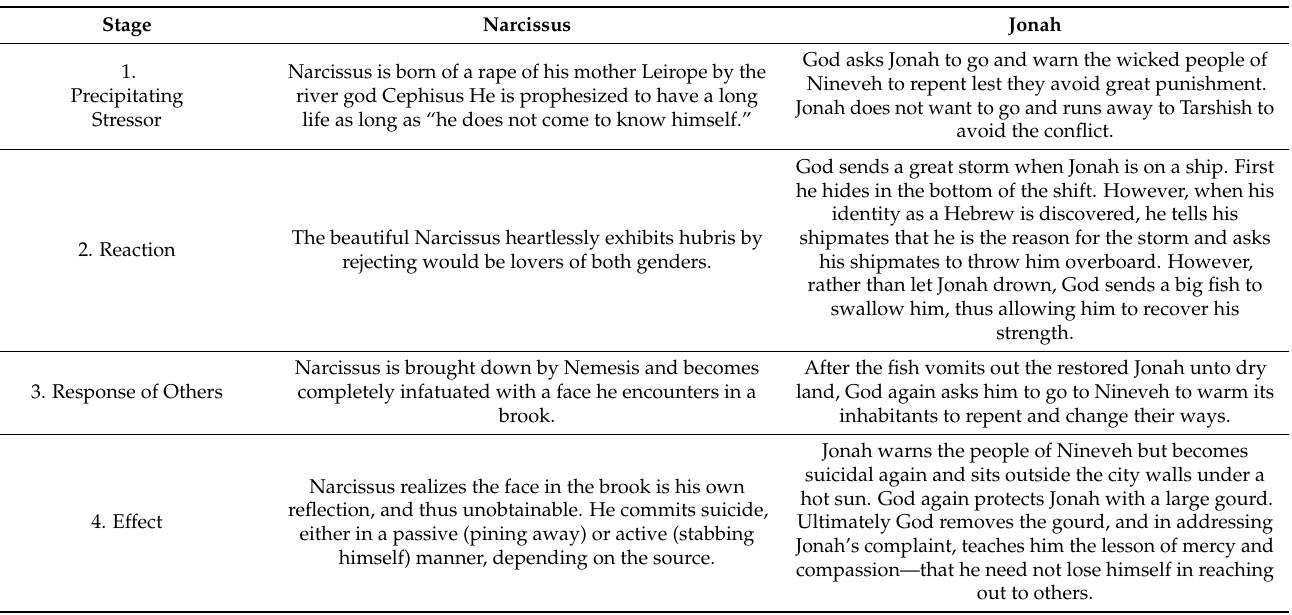
Table 7. Jonah against